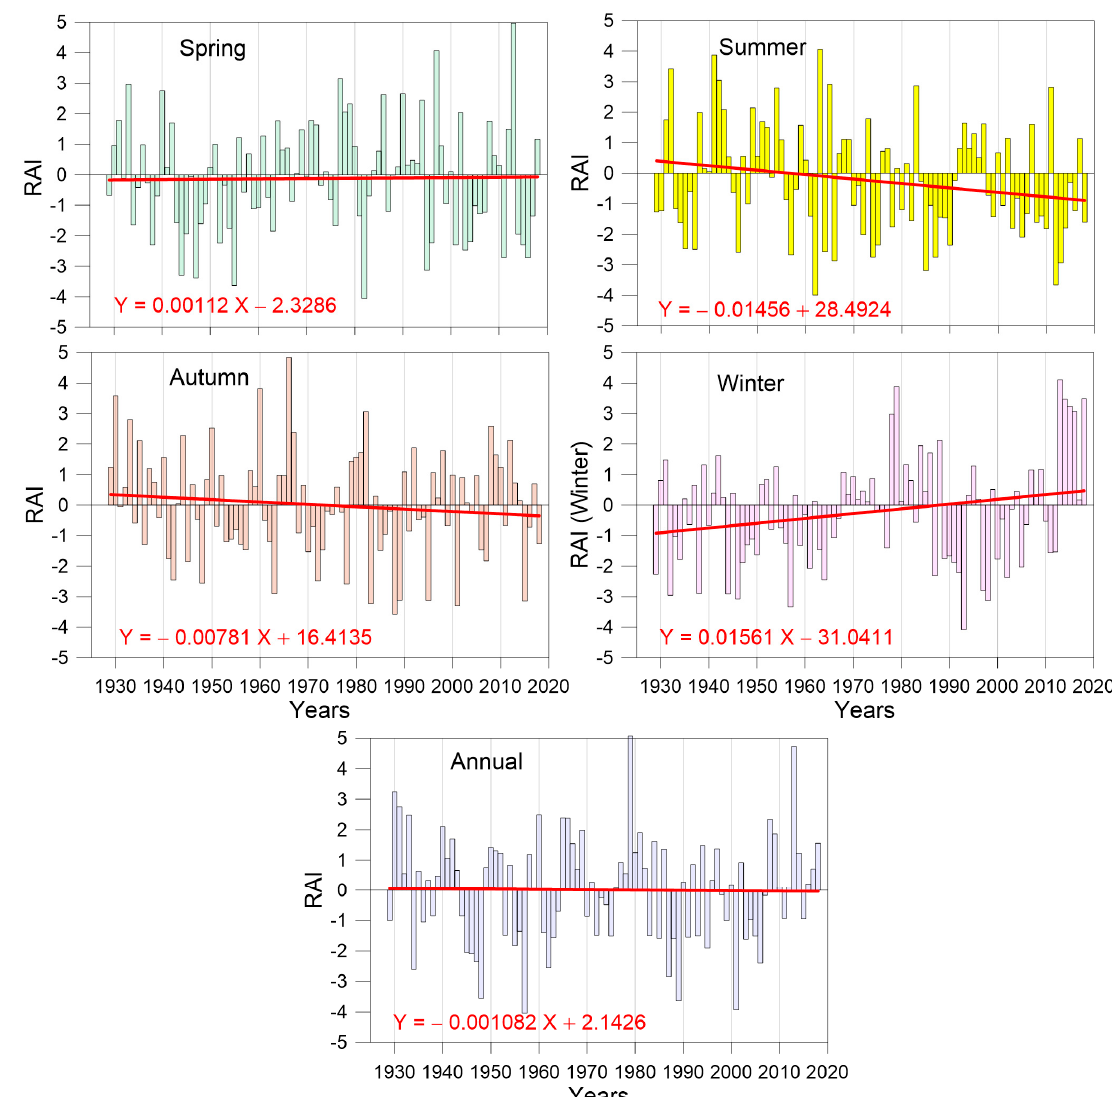
Figure 10. Representation of the seasonal and annual values of the RAI with the equations of regression lines.